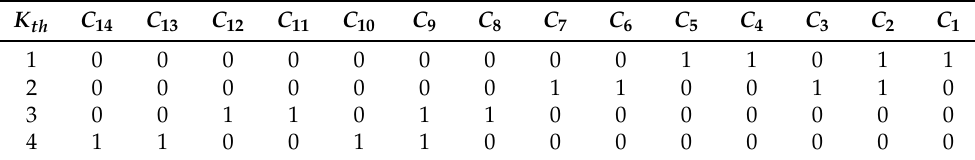
Table 5. FDW code sequence for W =